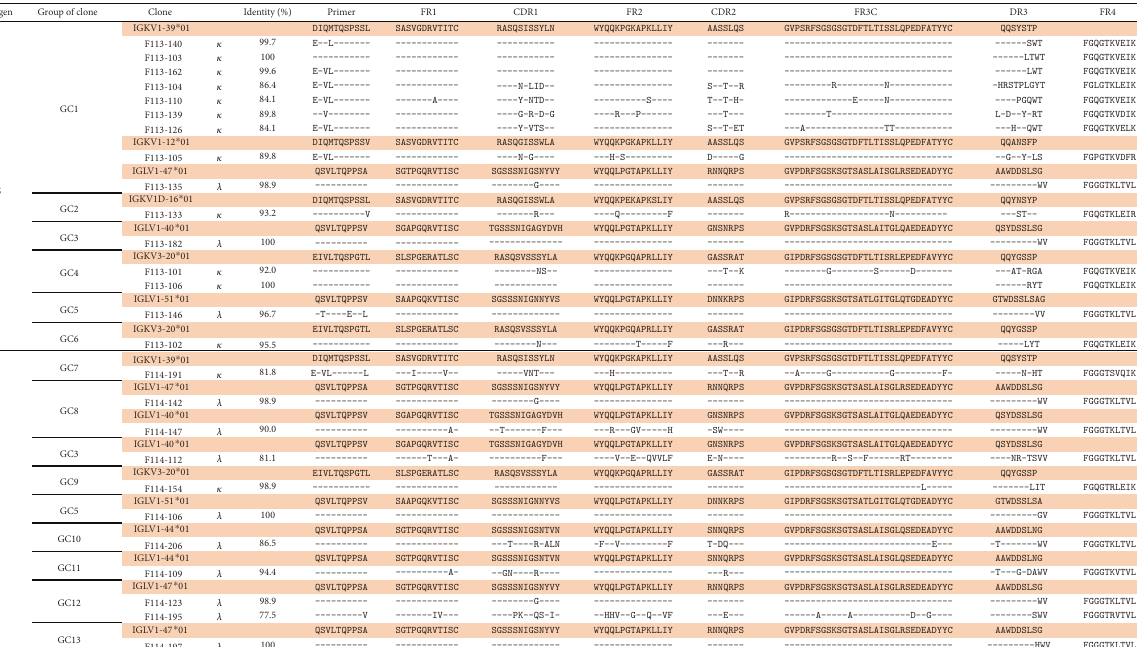
Figure 2: Amino acid sequences of the V region of the 26 Abs isolated in this study. Germline V genes, κ or λ , in the respective clones were L L assigned and their amino acid sequences are shown. Dash indicates the same amino acid as that of the germline gene. Amino acids that di ff er from that of germline gene are given. Identity (%) indicates the degree of similarity between the germline gene and that of the respective